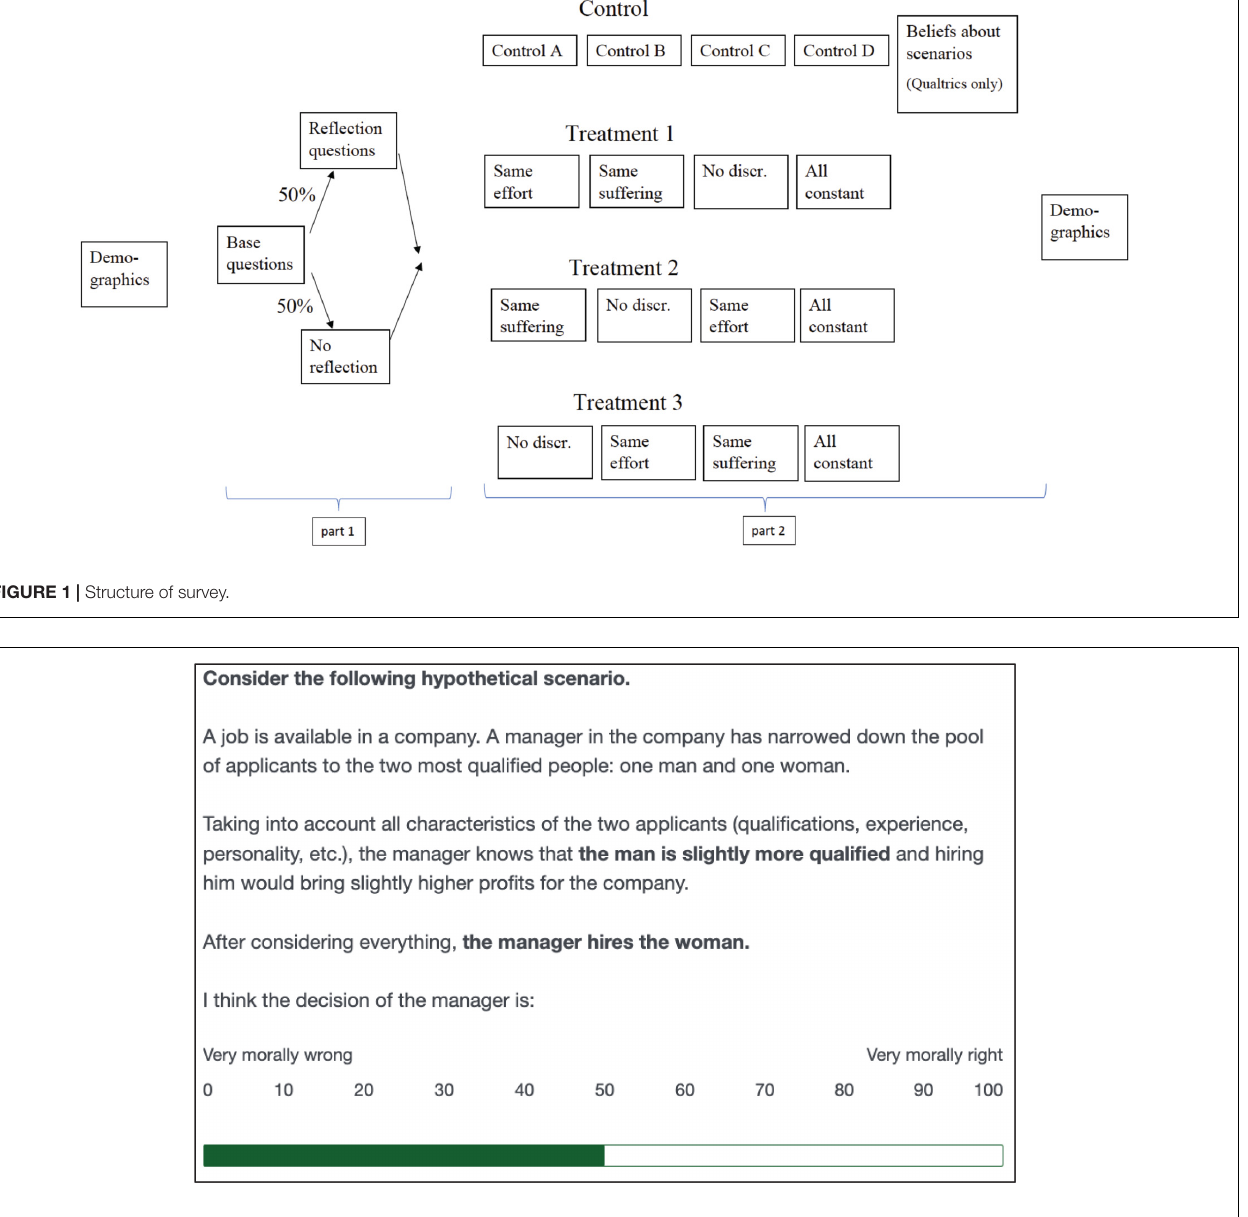
FIGURE 2 | Screenshot of discrimination-against-women base